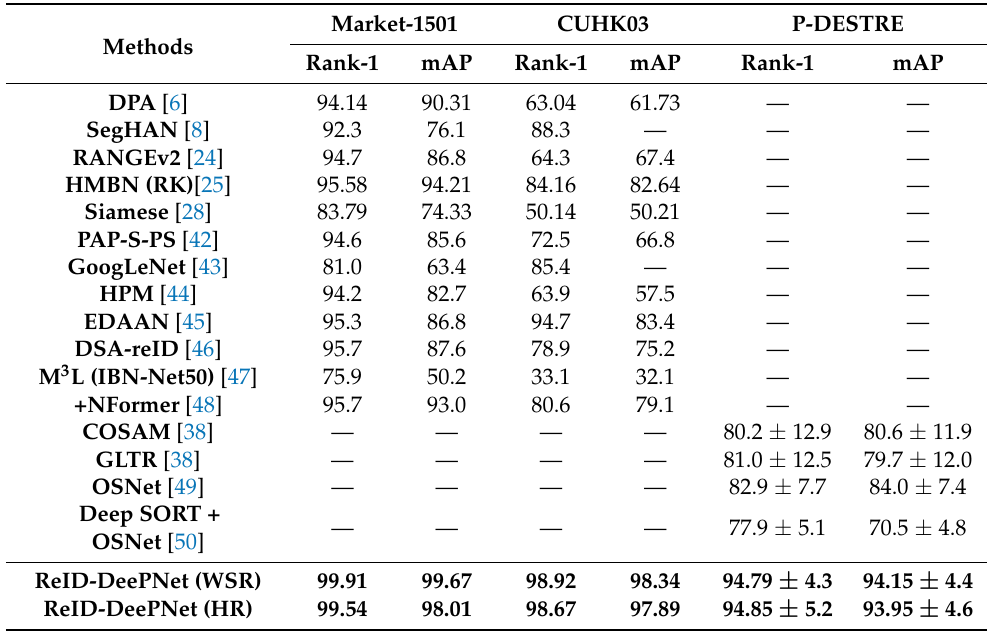
Table 11. Performance comparison with state-of-the-art approaches on three large-scale and challeng- ing ReID